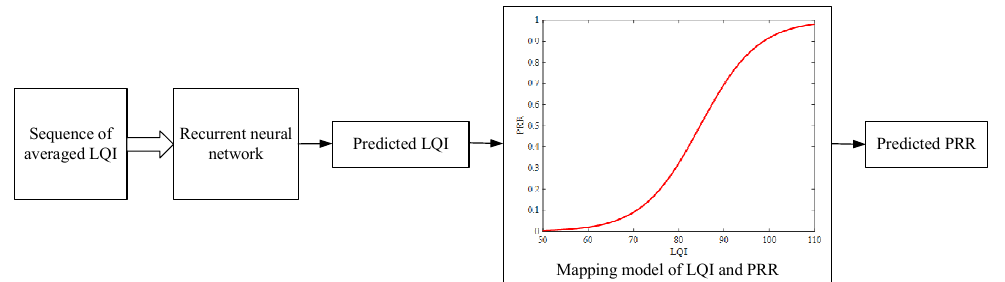
Figure 3. Structure of the proposed RNN-LQI.